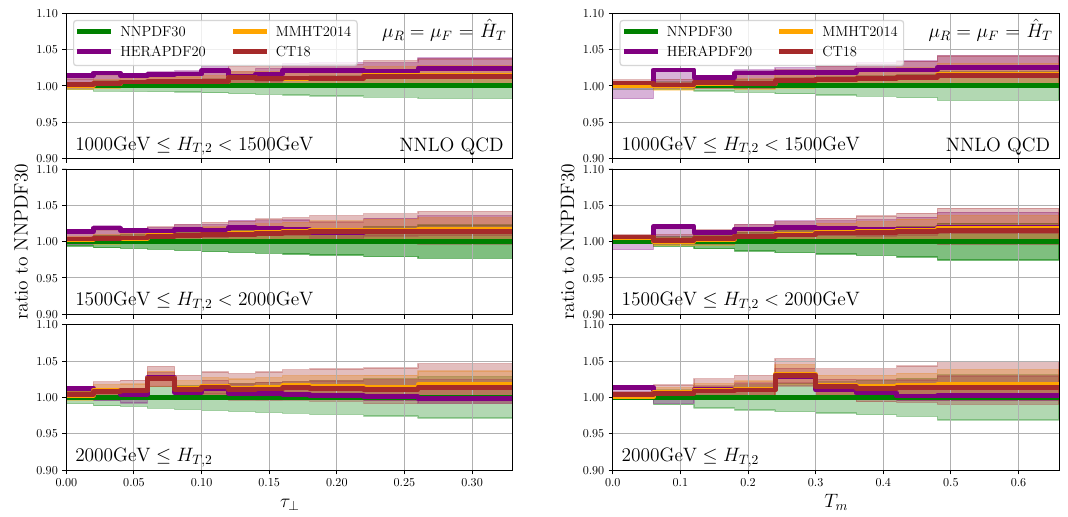
Figure 6 . The transverse thrust τ ⊥ (left) and the thrust minor T m (right) in three H T, 2 bins. The solid lines show fixed-order NNLO QCD predictions for different PDF sets normalised to NNPDF30. The coloured band show the estimated PDF